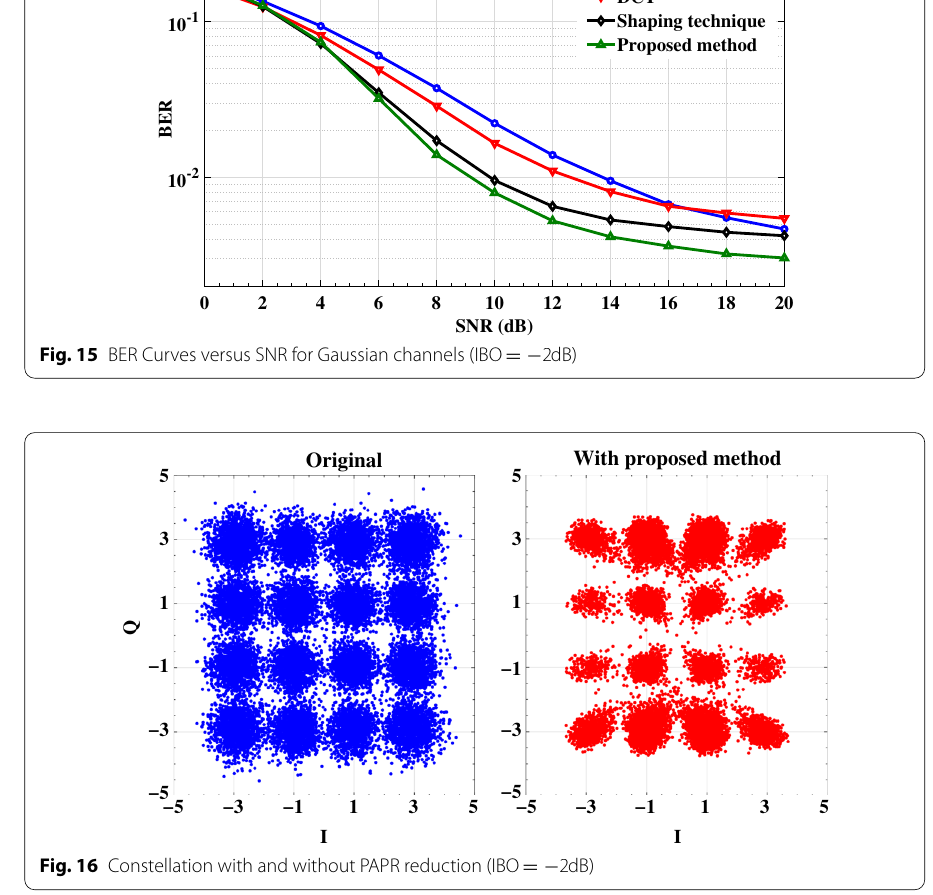
Fig. 16 Constellation with and without PAPR reduction (IBO